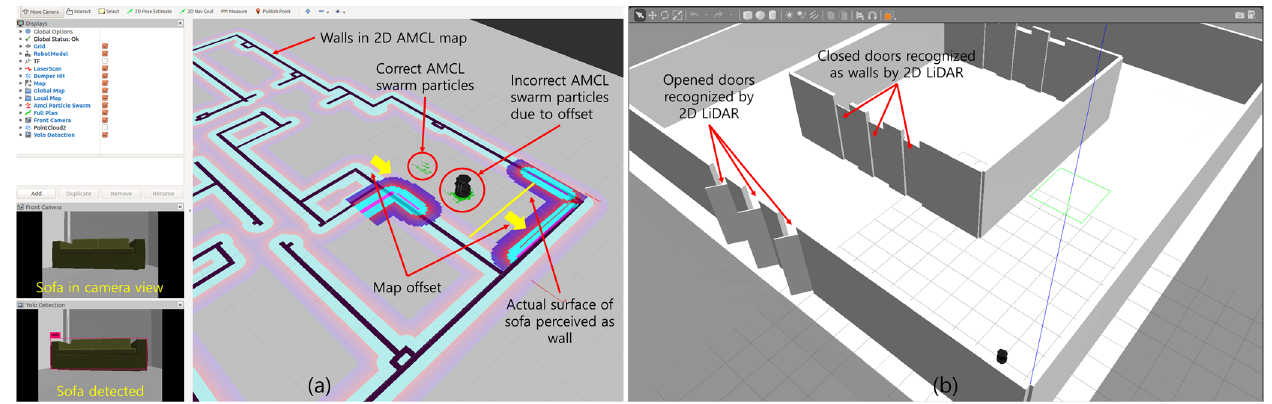
Figure 2. AMCL localization errors ( a ) due to the interpretation of the sofa front as a wall and ( b ) doors being mistakenly recognized as a contiguous wall. ( b ) doors being mistakenly recognized as a contiguous